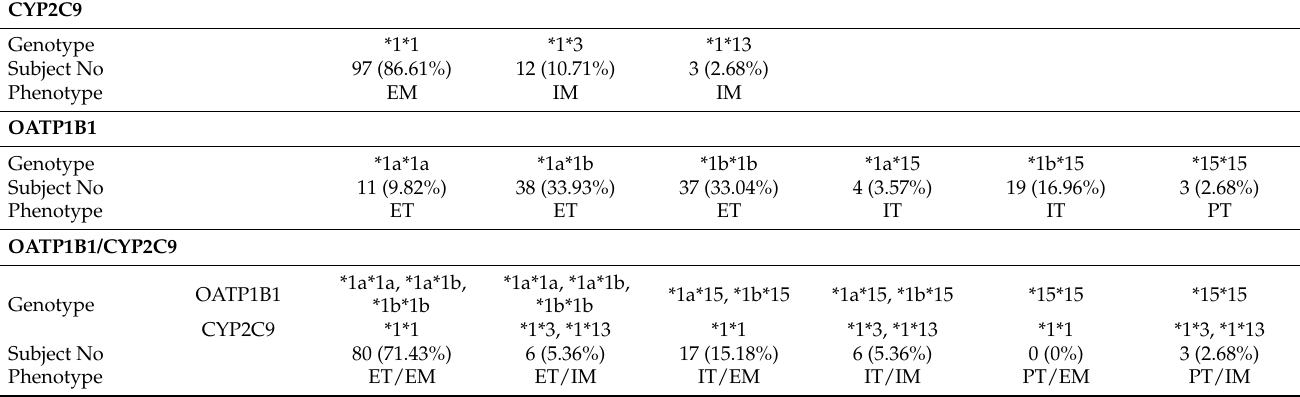
Table 1. Genotype ratio and phenotypic classification of CYP2C9 and OATP1B1 in healthy Korean men ( n = 112) who received torsemide